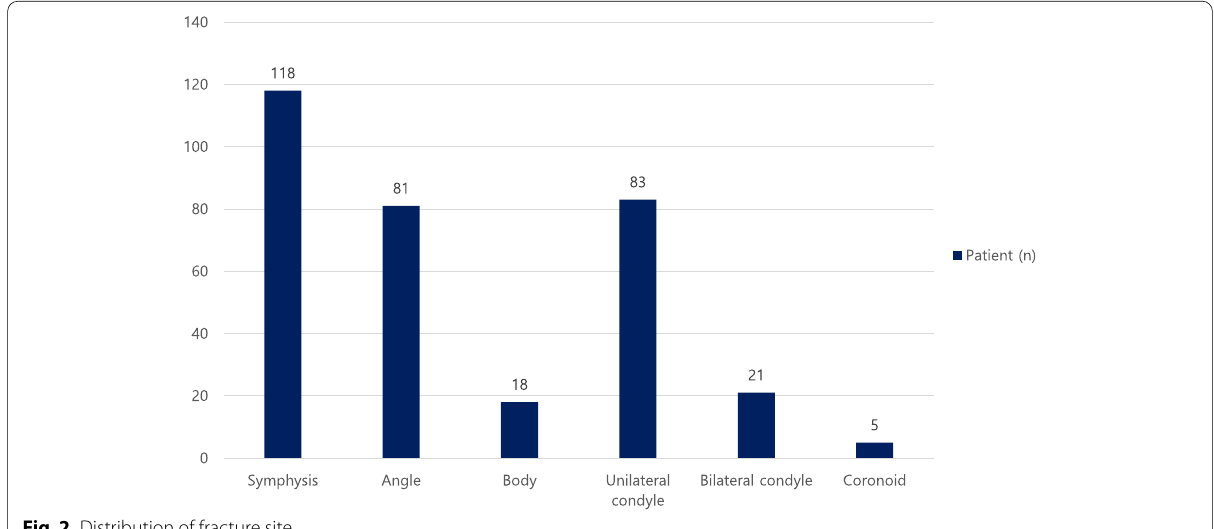
Fig. 2 Distribution of fracture